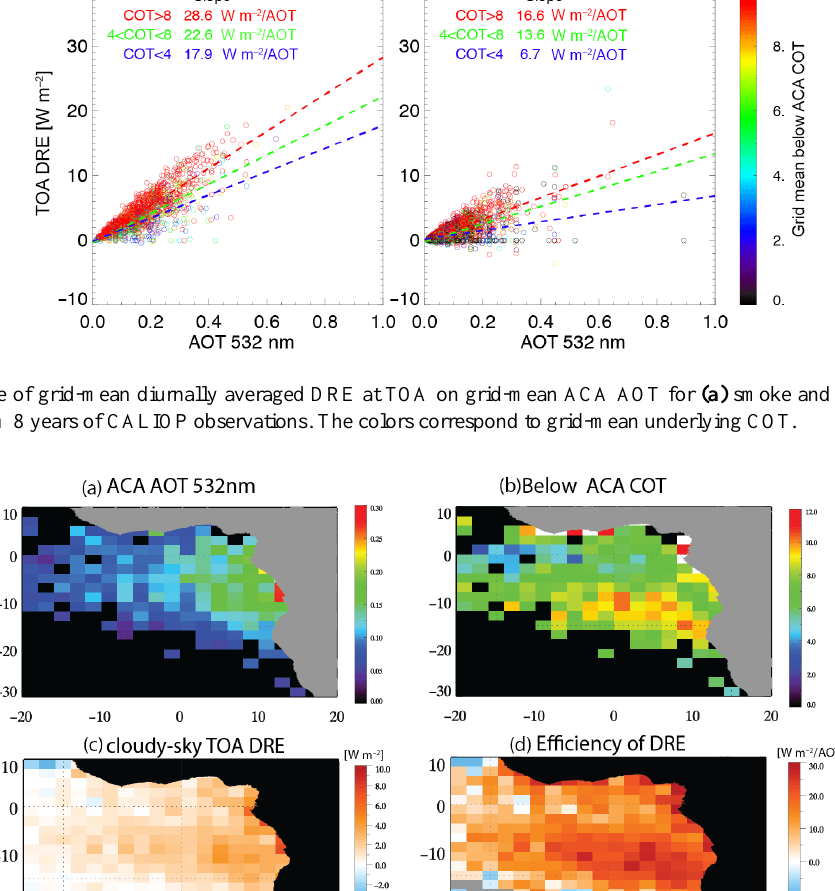
it highlights the importance of cloud optical thickness